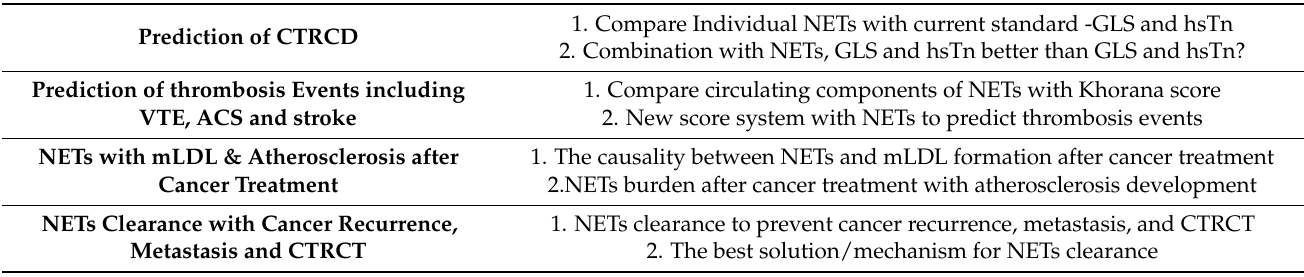
Table 1. Unsolved questions and future prospective studies in